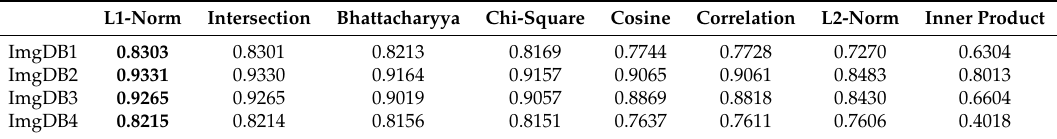
Table 2. Average retrieval precision of different histogram-based distance metrics on four test archives. The values are counted using the top 20 retrieval